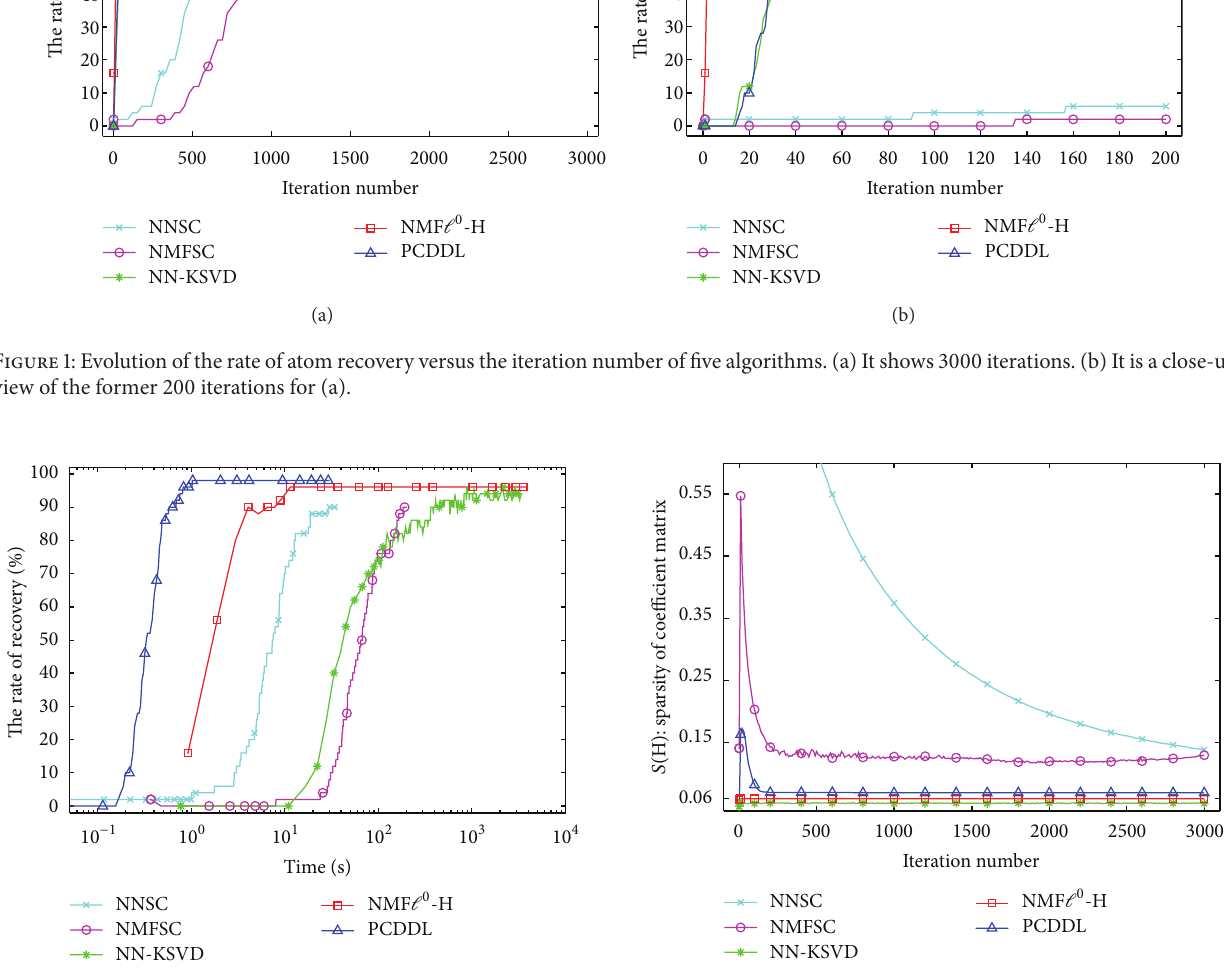
Figure 3: Evolution of the sparsity of the coefficient matrix versus the iteration number of five